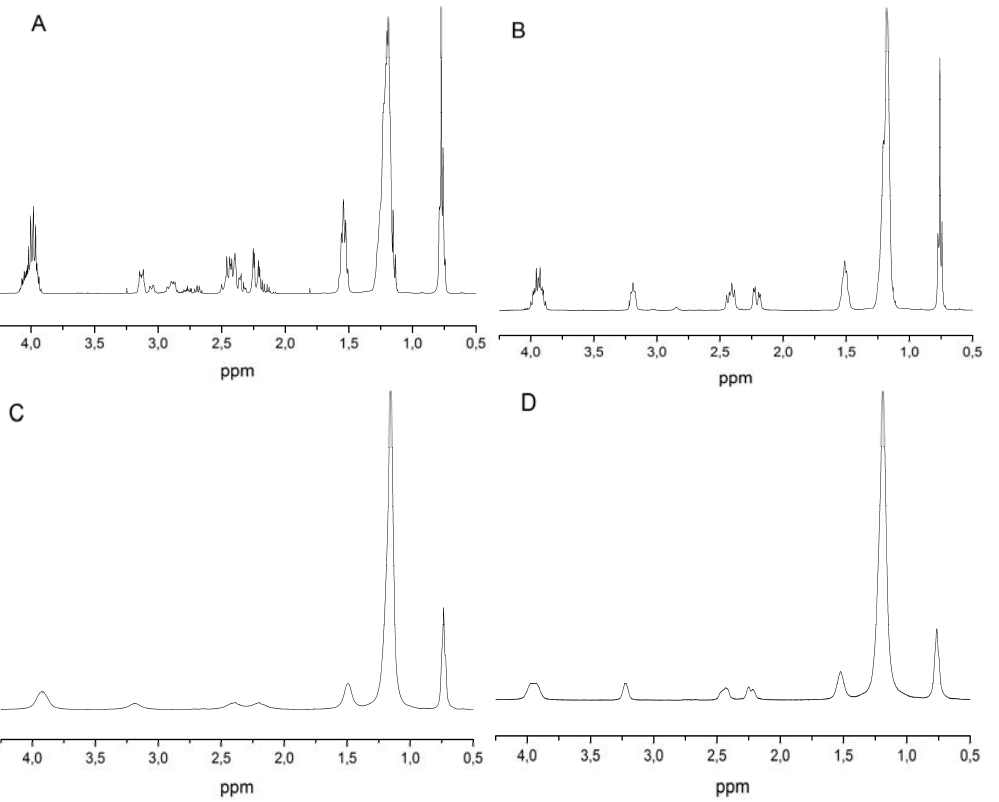
Figure 2. ( A ) 1 H-NMR spectrum of 4a ; ( B ) 1 H-NMR spectrum of 4b ; ( C ) 1 H-NMR spectrum of 4c ; ( D ) 1 H-NMR spectrum of 4d